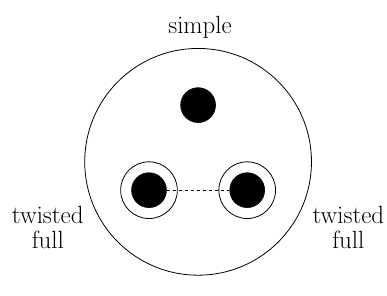
Figure 1 . The three-punctured sphere for the theory R 2 ; 2 N